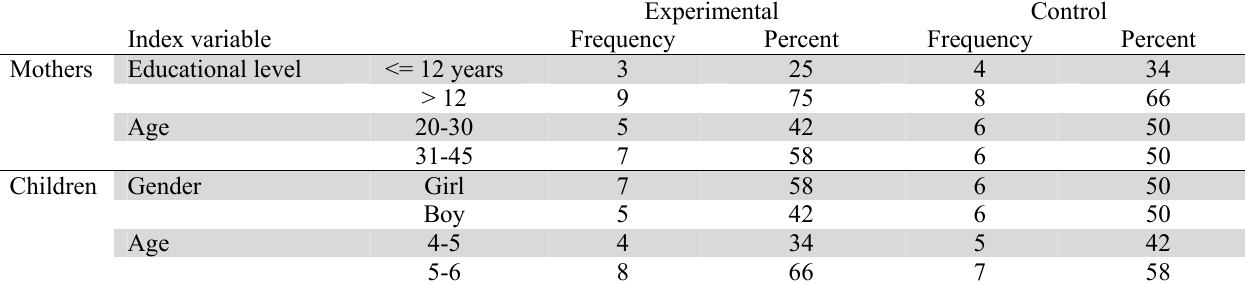
Demographic characteristics of sample